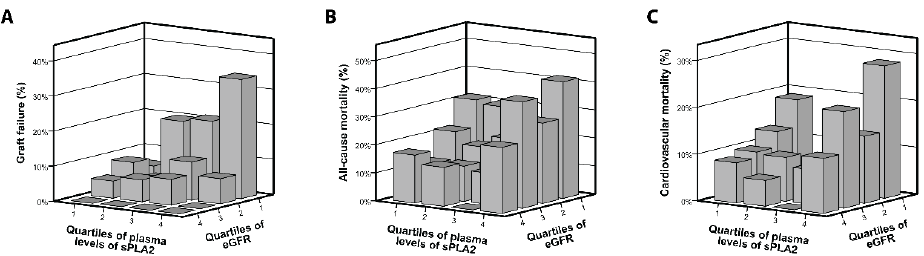
Figure 3. Graft failure ( A ), all-cause mortality ( B ), and cardiovascular mortality ( C ) according to quartiles of plasma levels of group IIA secretory phospholipase A 2 (sPLA 2 ) and estimated glomerular filtration rate (eGFR).